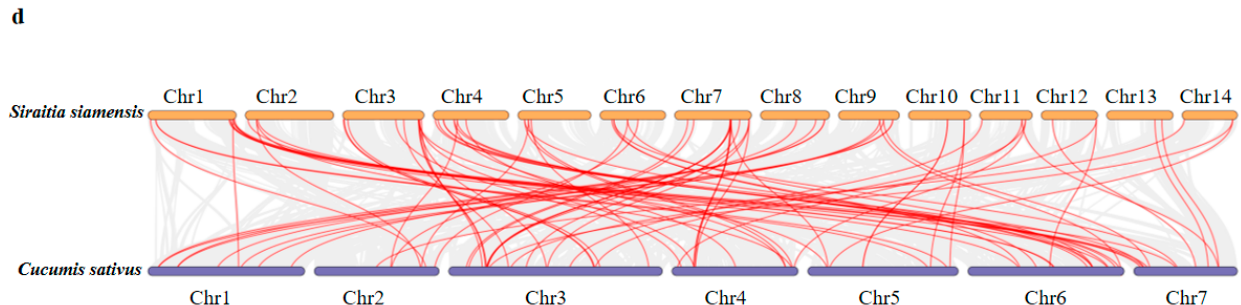
Figure 5. Chromosome-level analysis of the SsWRKY gene family in the S. siamensis genome assembly. ( a ) Chromosomal location of SsWRKY genes and their collinear relationships are shown in the circle diagram. Gray lines indicate all synteny blocks in the S. siamensis genome, and red lines represent segmentally duplicated gene pairs. Chromosomes 1–9 are denoted by different colors; ( b – d ) Collinearity analysis of WRKY genes between S. siamensis and O. sativa , A. thaliana , and C. sativus . The syntenic gene pairs of SsWRKY genes are tagged with red lines, and the collinear blocks are presented by gray lines.